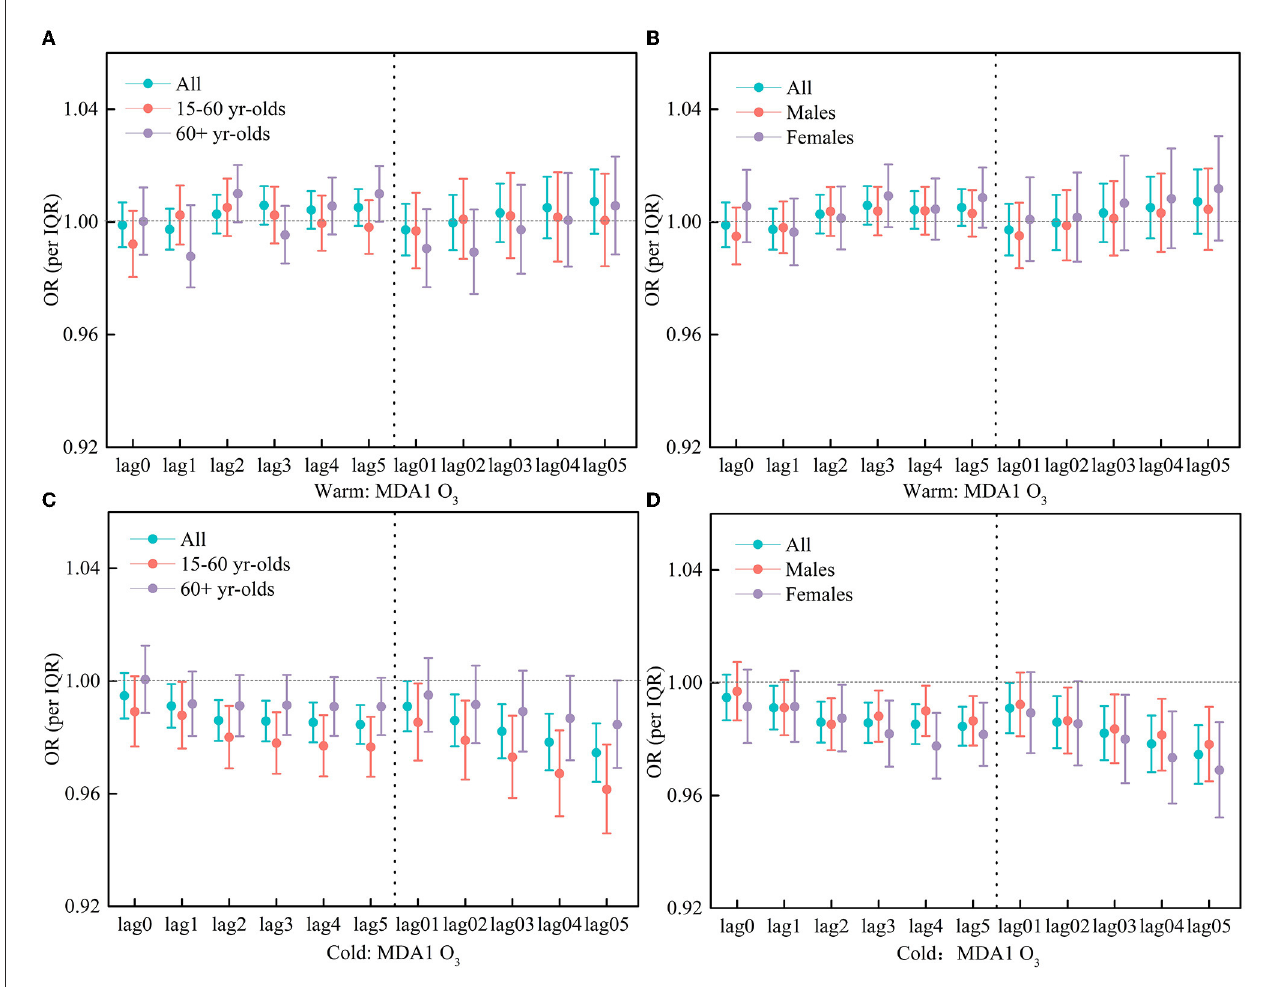
FIGURE5 (A–D) OR of respiratory hospitalization visits for an increase of per IQR in MDA1 O3 during the warm periods (May to October) and the cold periods (November to April).